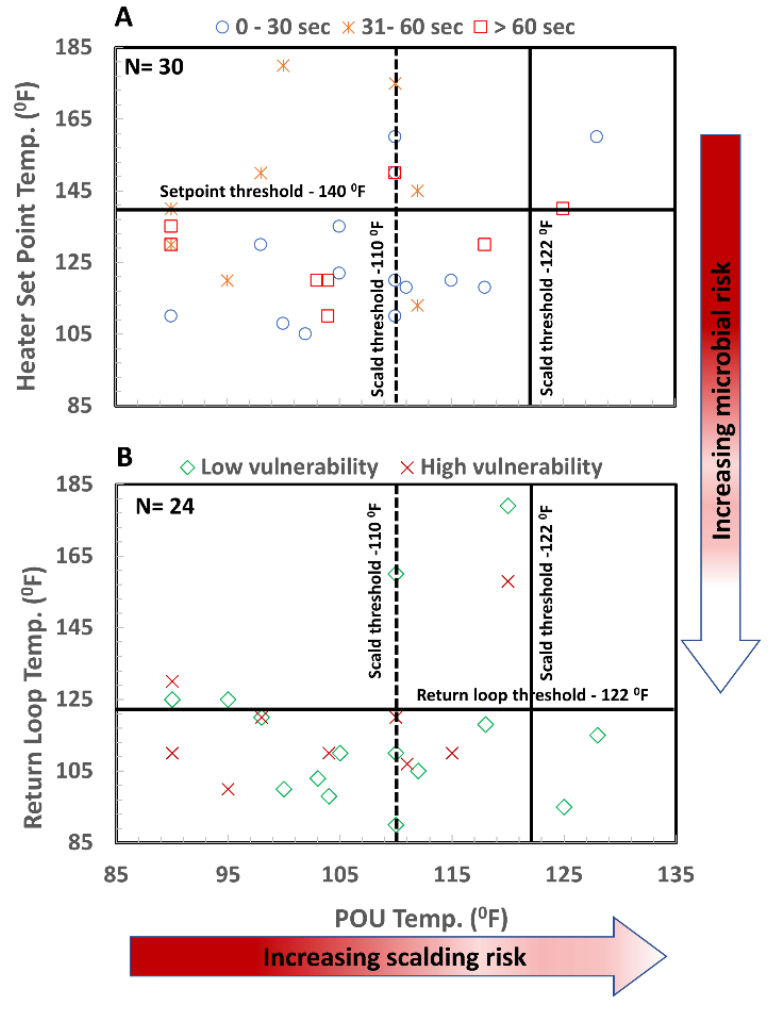
Figure 2. POU temperature plotted against ( A ) water heater setpoint temperature (marker type shows time to tap) and ( B ) return loop temperature (marker type shows occupant vulnerability). The vertical lines represent temperature threshold lines for safety against scalding at 110 °F (43 °C) (dotted) and 122 °F (50 °C) (solid). The horizontal lines correspond to temperature guidance for control of premise plumbing pathogens (i.e., Legionella spp.) at 140 °F (60 °C) for setpoint ( A ) and 122 °F (50 °C) for return loop ( B ).